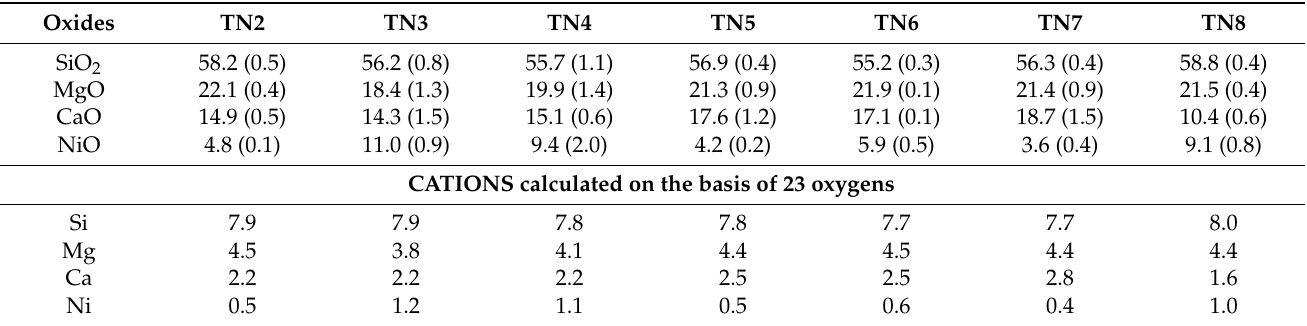
Table 2. Representative analyses of Ni-doped tremolite, normalized oxide weight percent and cation number (a.p.f.u.) calculated on the basis of 23 oxygens, from four EPMA analyses on tremolite